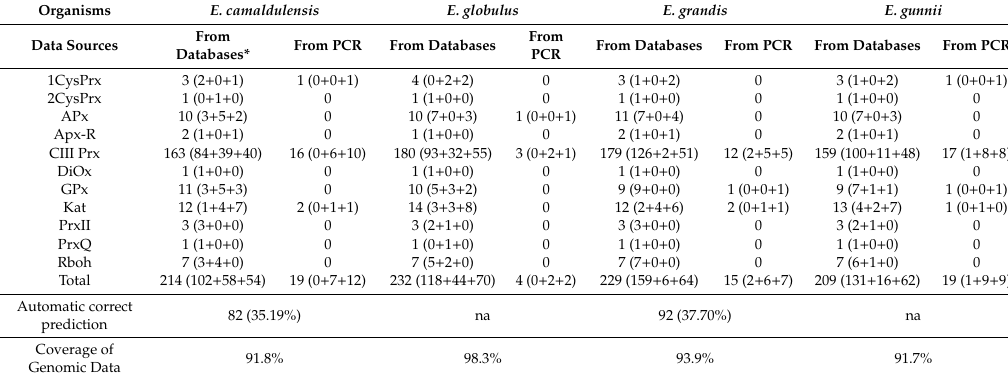
Table 1. ROS gene numbers of four Eucalyptus species annotated from various database sources and from experimental detection performed in this